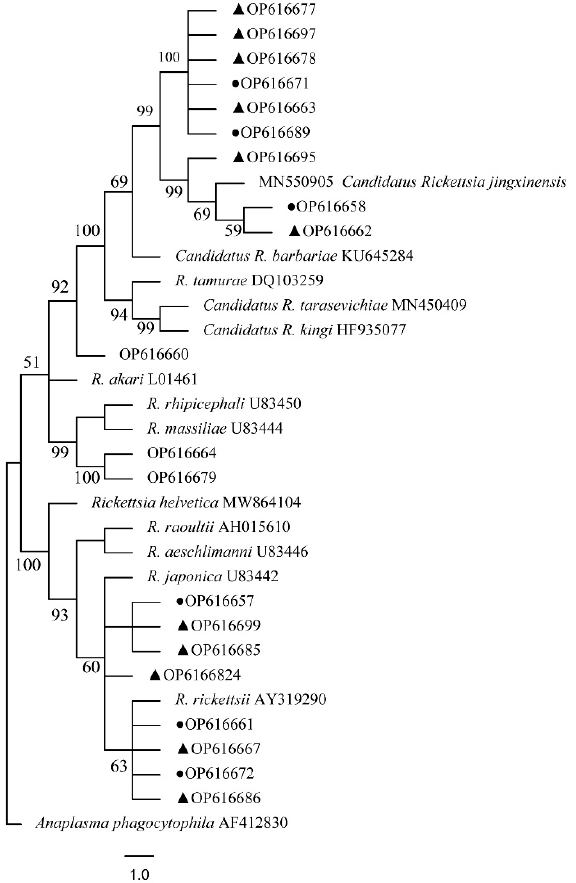
Figure 14. Phylogenetic tree of Rickettsia spp. in ticks based on partial ompA gene sequence similarity. The sequence from H. flava obtained in this study is indicated with a black triangle, and the sequence from H. longicornis obtained in this study is indicated with black dots. Sequences were aligned using the MEGA X (version 10.0) software package. Phylogenetic analysis was performed by the neighbor ‐ joining method (N J. method), and bootstrap values were estimated for 1000 replicates. The Kimura two ‐ parameter model was used as a substitution model for the calculation of the phylogenetic trees. 4. Discussion In recent years, more and more attention has focused on emerging TBPs and ticks. Additionally, a wide variety of pathogenic and non ‐ pathogenic bacteria have been iden ‐ tified. In this study, the bacterial community diversity of Haemaphysalis spp . in Shanghai was analyzed and compared based on the 16S rDNA high ‐ throughput sequencing tech ‐ nique combined with nested PCR to survey TBPs in Haemaphysalis spp. collected from Shanghai, China. It is found that the 16S rDNA V3 ‐ V4 variable region sequence of bacteria can effectively detect the bacterial community composition and diversity of H. flava and H. longicornis . At the same time, sequencing data can also be used to evaluate the relative abundance of bacteria and the differences in flora structure between different groups. In this study, two species of Haemaphysalis ticks: H. longicornis and H. flava , were col ‐ lected. H. flava often lives in mixed forests and fields, and their hosts are mainly pigs, pig badgers, horses and sheep, while H. longicornis mainly live in secondary forests, moun ‐ tains, or hilly marginal areas, and their hosts are mainly cattle, horses, sheep, goats, bears, hedgehogs, etc.) [22]. However, in the past, H. longicornis was the main tick species in Shanghai [21], but today, H. flava , which has spread all over Shanghai, is the main tick species. In light of the ongoing geographical expansion of ticks caused by climatic change, as well as their increased ability to harbor new pathogens, public health concerns have been raised for both humans and animals [21,30–32]. Many new tick ‐ borne pathogens